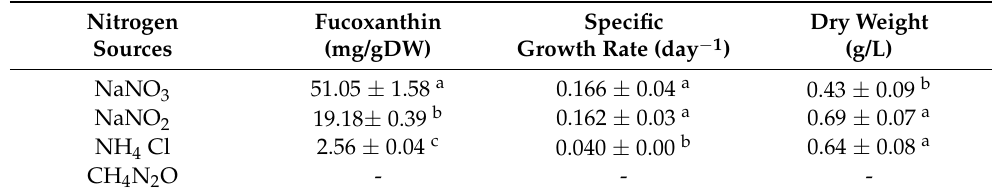
Table 2. Data for the production of N. shiloi and variation in the fucoxanthin amount using different N-sources.